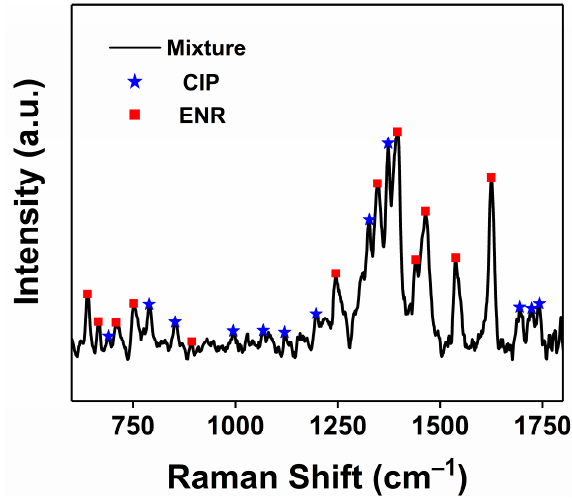
Figure 6. SERS spectra of a mixture of CIP and ENR using the CdSSe NFs as SERS